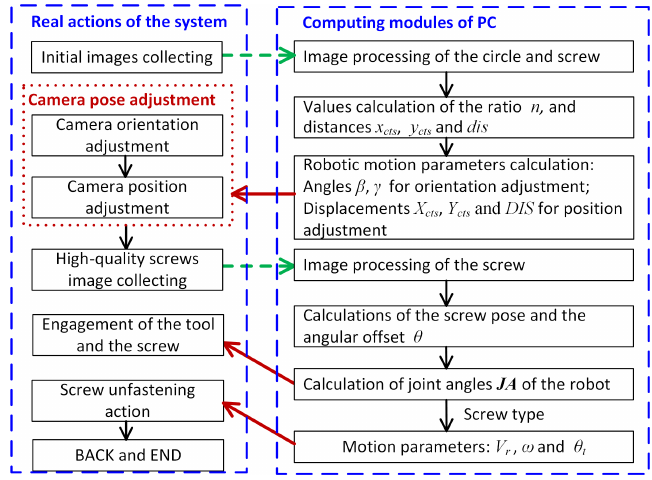
Figure 22. Detailed flowchart of the unfastening strategy used in the experiment.